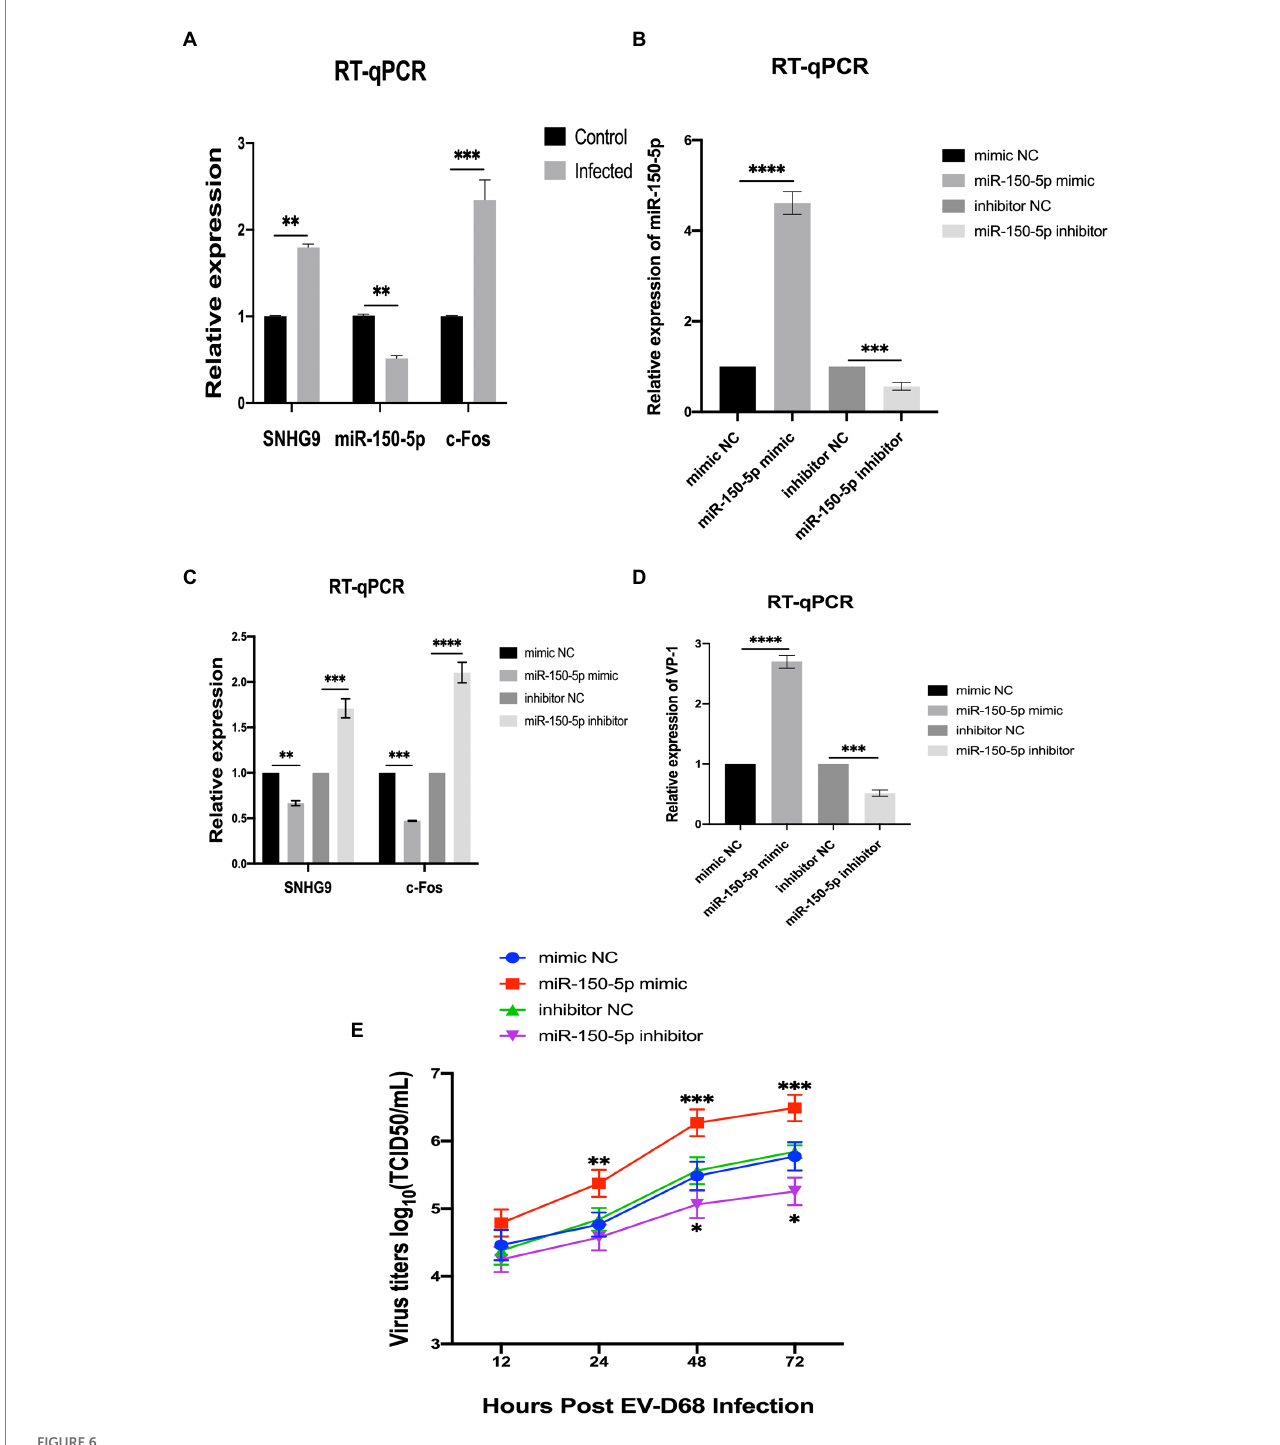
FIGURE 6 LncRNA SNHG9/miR-150-5p/c-Fos axis validation (A) qRT-PCR was utilized to determine the expression of SNHG9, miR-150-5p, and c-Fos in RD cells. RD cells were transfected with miR-150-5p mimic and inhibitor and then infected with EV-D68 for 24 h. (B–D) qRT-PCR for validation of RNA levels of SNHG9, miR-150-5p, VP1, and c-Fos in RD cells (* p < 0.05, ** p < 0.01, *** p < 0.001, **** p < 0.0001). (E) Viral titer assay for verification of viral replication levels. The data are expressed as mean standard deviation ( n = 3) * p < 0.05, ** p < 0.01, *** p < 0.001 in comparison to the mimic NC and inhibitor NC